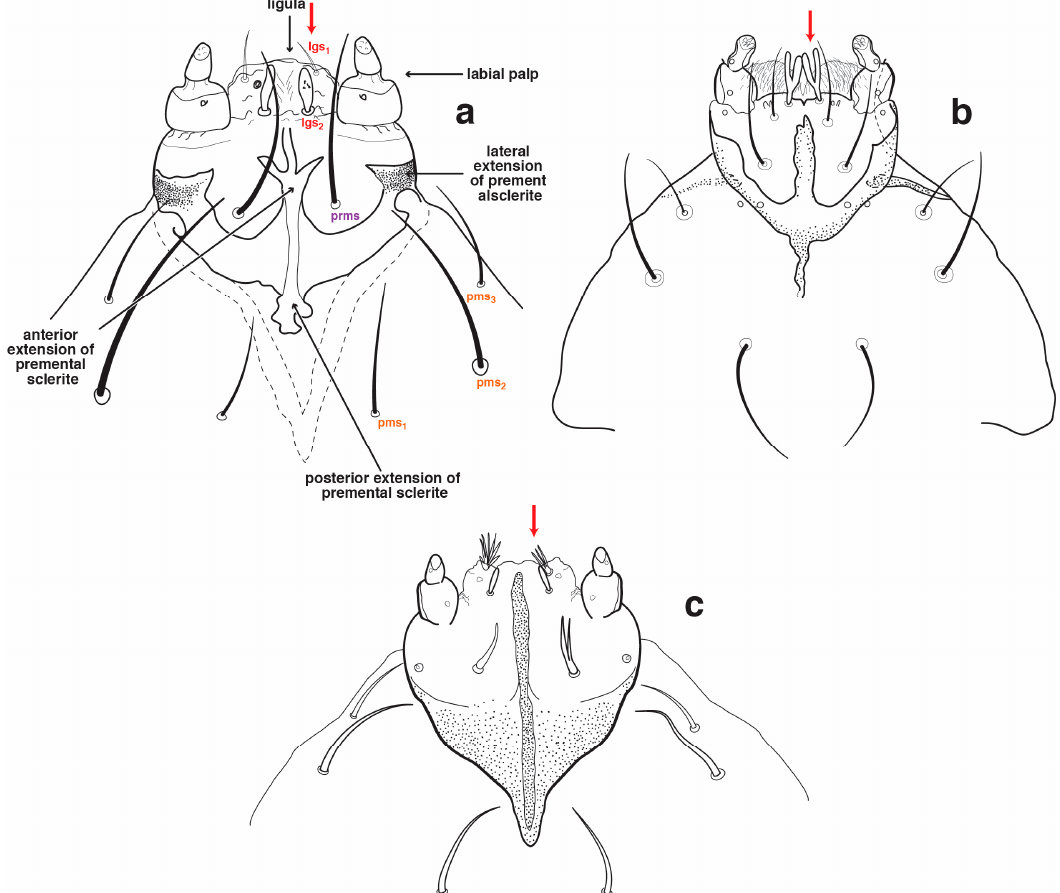
Figure 52. Labium, larva: ( a ) Poteriophorus ; ( b ) Eucalandra ; and ( c ) Yuccaborus . Lgs1, 2 : ligular setae. 3. Position of postmental setae (pms1, 2, 3) (Figure 53) a. Linear Dryophthorus , Mesocordylus (probably), Stenommatus b. Not linear Cactophagus , Cosmopolites , Cyrtotrachelus , Diathetes, Diocalandra , Eucalandra , Eugnoristus , Foveolus, Metamasius , Myocalandra, Nassophasis , Nephius (=Anius) , Odoiporus, Paramasius, Phacecorynes , Polytus , Poteriophorus , Rhabdoscelus, Rhodobaenus , Rhynchophorus , Scyphophorus, Sipalinus , Sitophilus, Sparganobasis, Sphenophorus , Temnoschoita , Trigonotarsus, Trochorhopalus , Tryphetus, Yuccaborus Not included: Dryophthoroides , Dynamis , Rhinostomus , Xerodermus